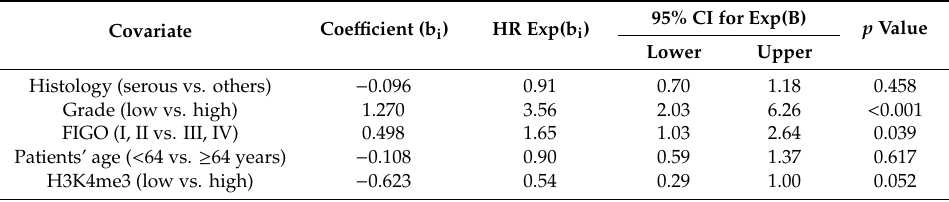
Table 2. Multivariate analysis.